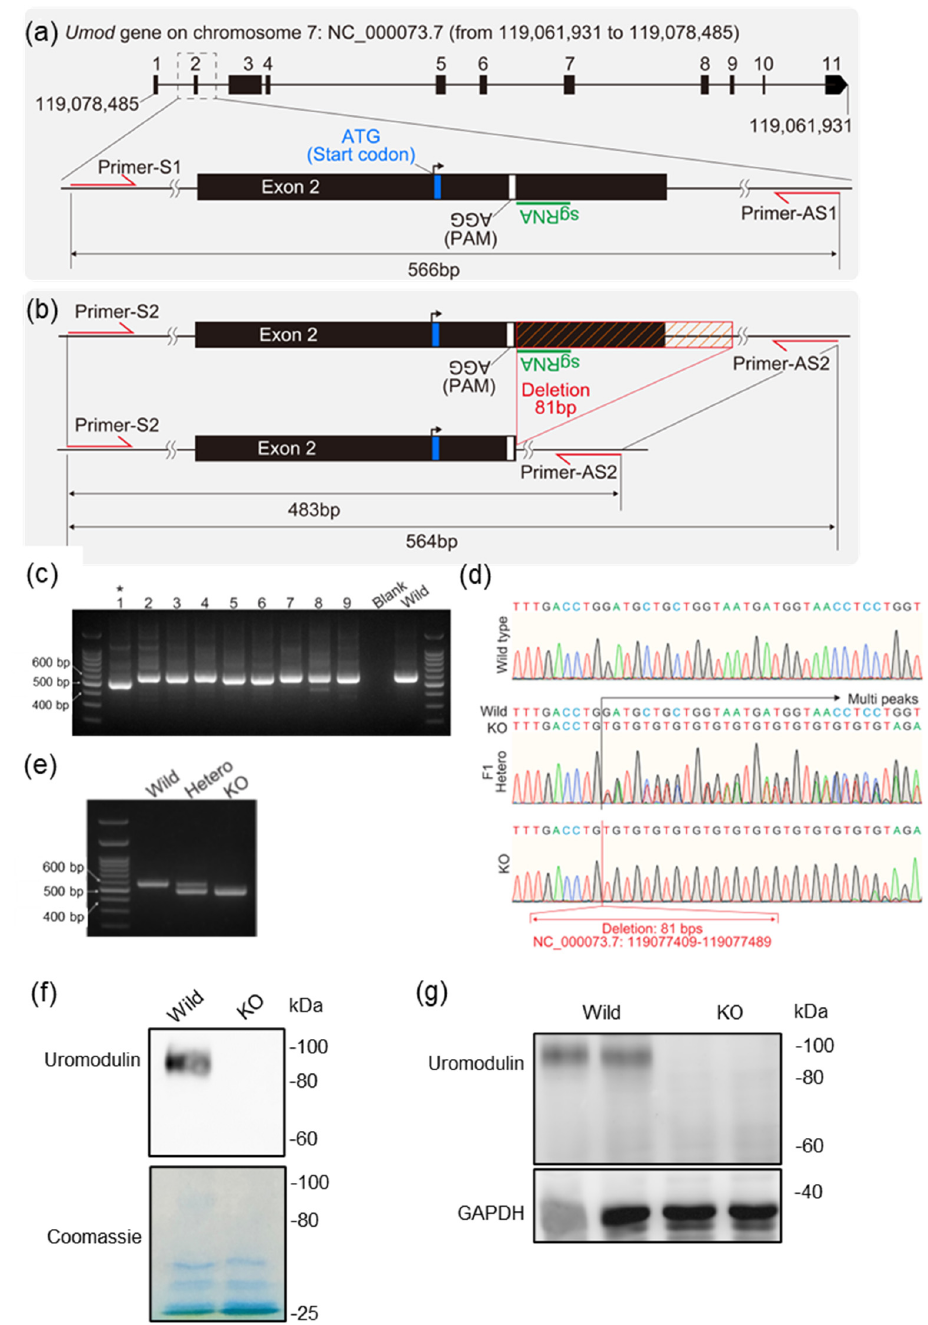
Figure 4. Generation of Umod − KO mice. ( a ) The Umod locus on chromosome 7, sgRNA-targeted region, and PCR primers are shown. ( b ) The region deleted using the CRISPR/Cas system is shown. ( c ) Electropherograms with PCR screening of F0 generation mice are shown. F0 mouse No. 1 marked with an asterisk was selected as the founder mouse. The electropherogram with the selected founder’s band is shown. ( d ) Chromatograms of sequence analysis are shown. The lengths of the horizontal axis of the chromatogram images were adjusted to the same length. Chromatograms of F1 mice show multiple peaks due to heterozygosity. Eighty − one base pairs (from 119,077,409 to 119,077,489 on NC_000073.7) were deleted using the CRISPR/Cas system. ( e ) Electropherogram of genotyping PCR is shown. Deletion of uromodulin was confirmed using western blot analysis for uromodulin in urine ( f ) and kidney samples ( g ). PAM: proto − spacer − adjacent motif.